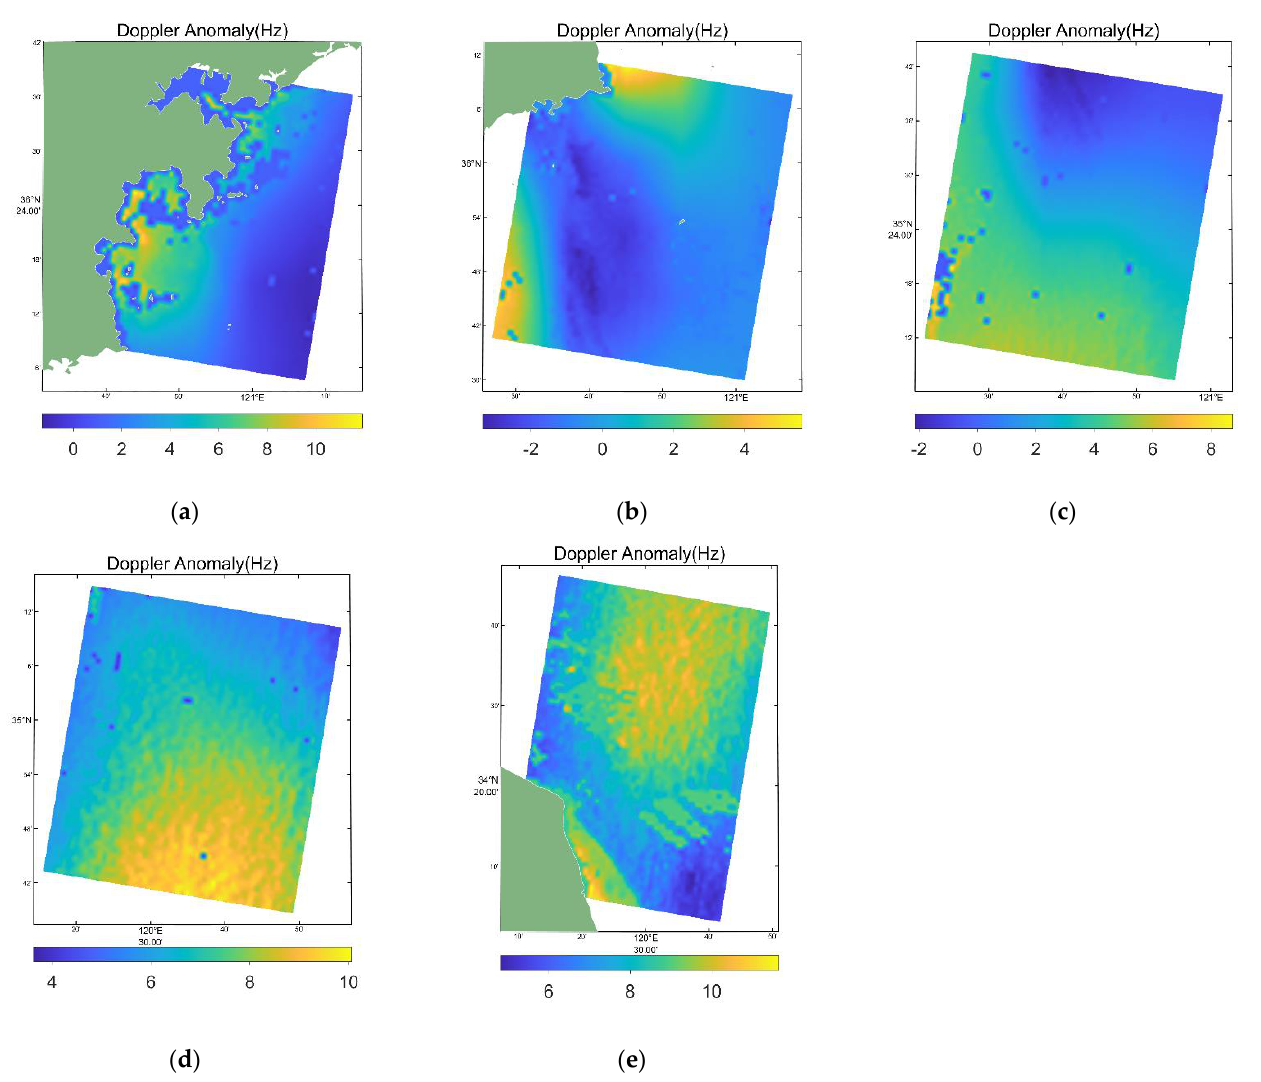
Figure 9. Retrieved radial velocity of SAR images. (a)~(e) are the Retrieved radial velocity from the five scenes in the figure 1.